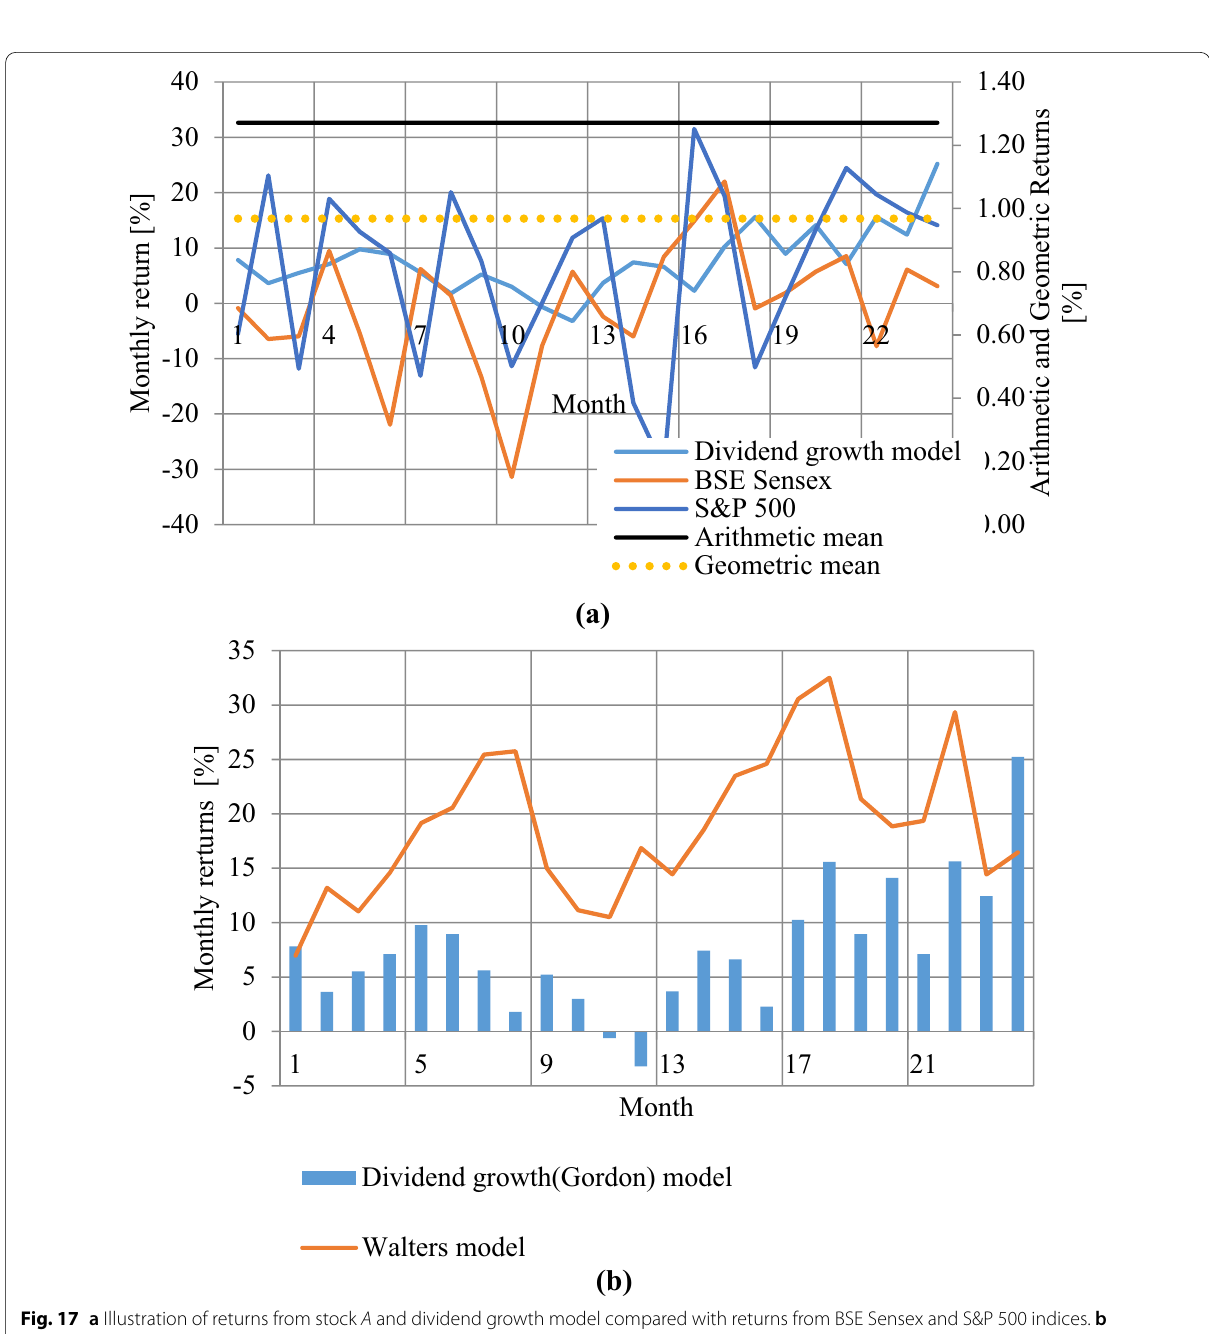
Fig. 17 a Illustration of returns from stock A and dividend growth model compared with returns from BSE Sensex and S&P 500 indices. b Comparison of returns according to Gordon growth and Walter’s dividend model for a mean growth rate of 7.53 % and equity capitalization rate of 30%